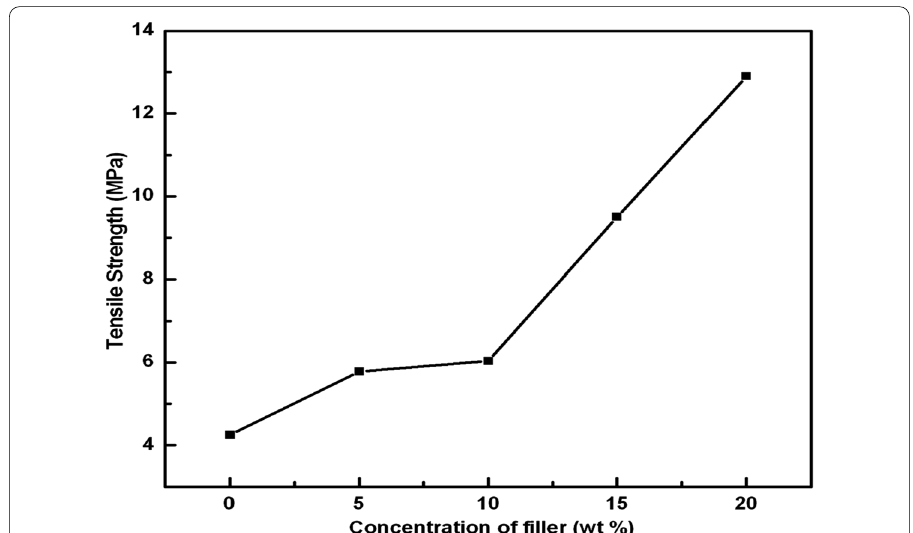
Fig. 6 Variation of tensile strength with the different concentration of nanochitosan incorporated polymer electrolytes